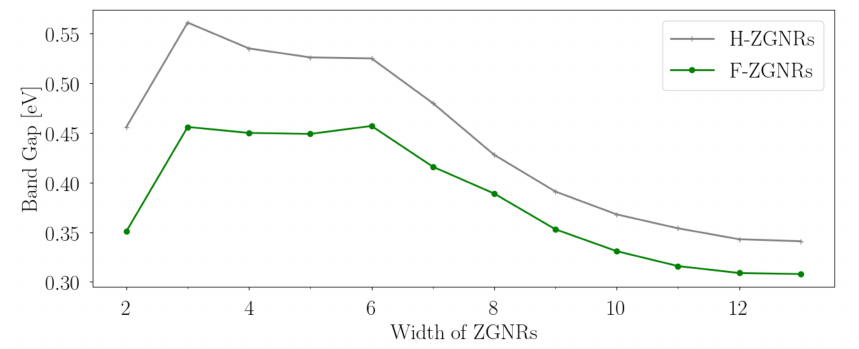
Figure 2. Bandgaps in eV for 2–13 widths of ZGNRs at the PBE level. For the stability, the dangling bonds at the edge are saturated with hydrogen and fluorine atoms,